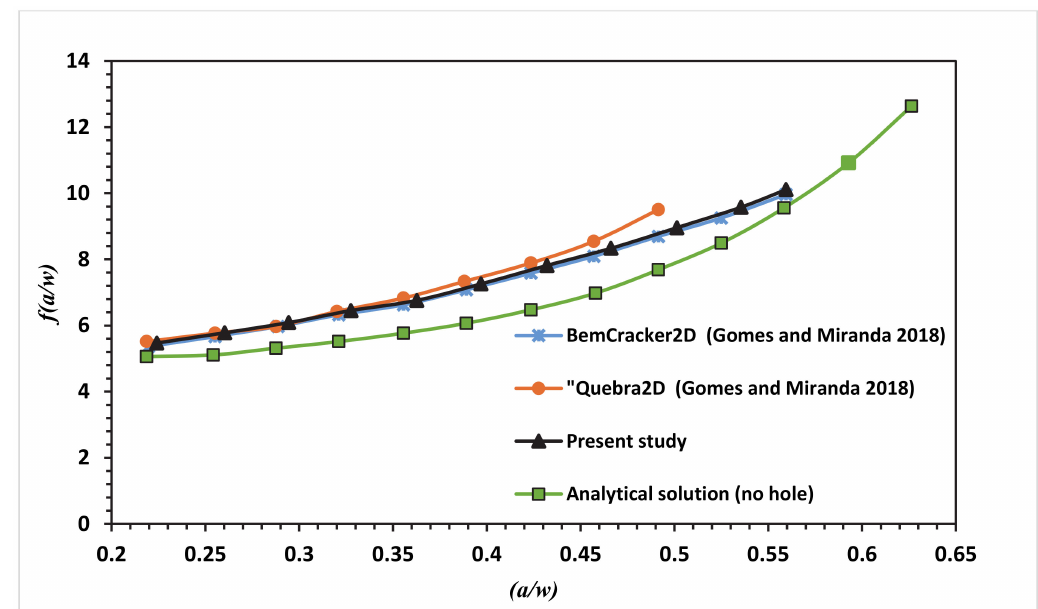
Figure 11. Dimensionless SIF of the modified compact tension specimen CTS02 compared to the work of Gomes and Miranda [16].